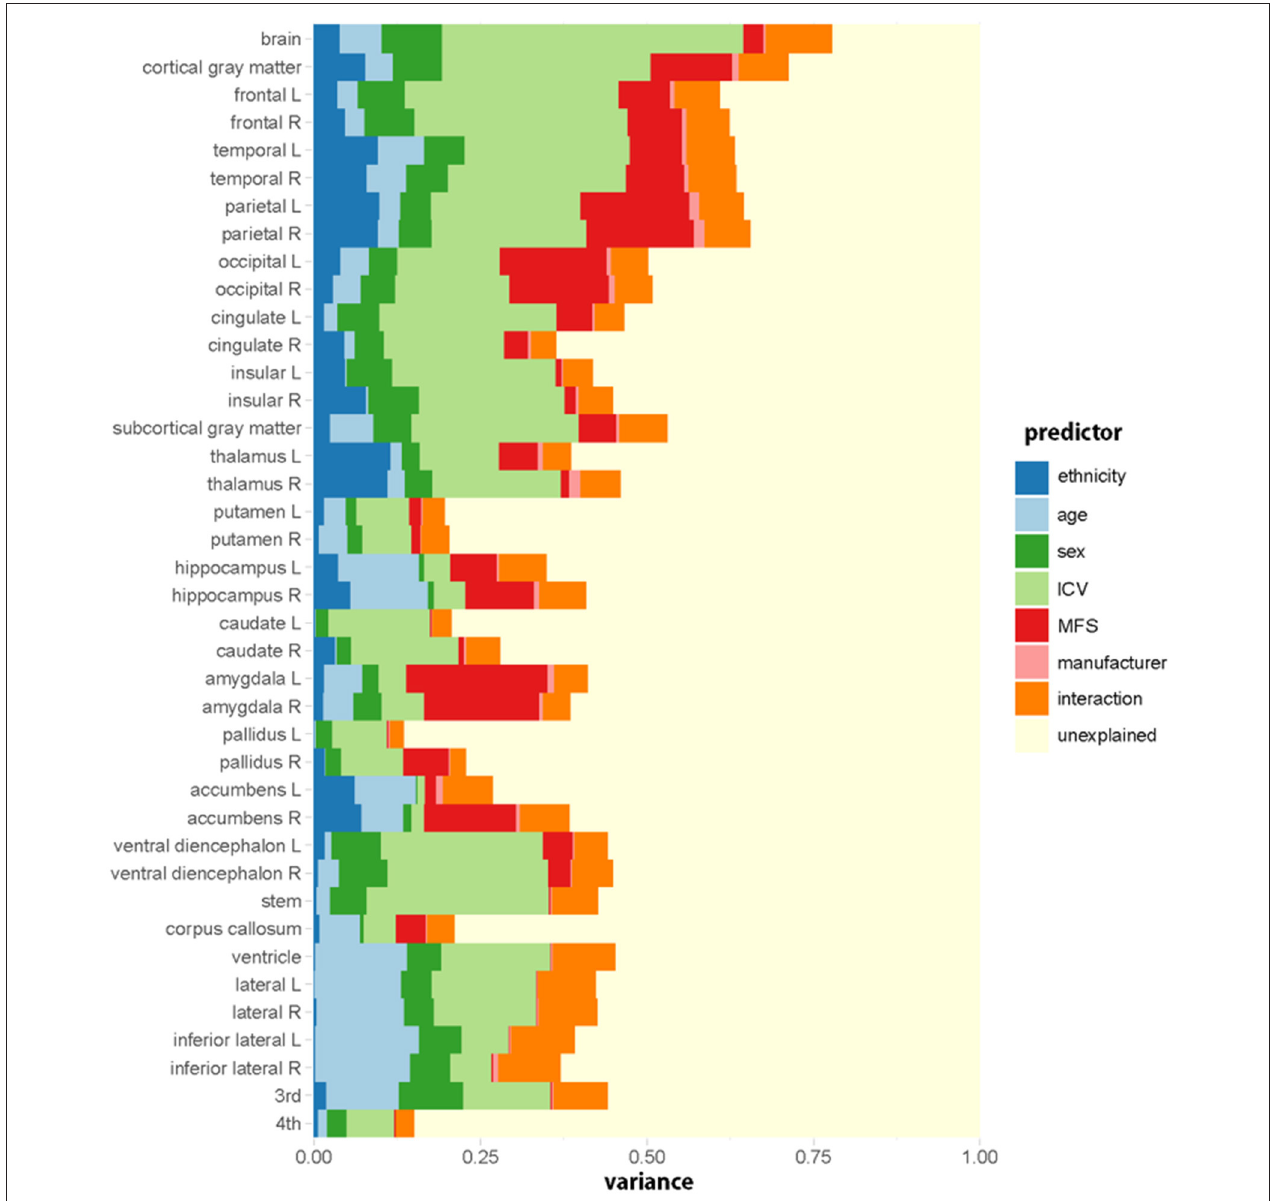
FIGURE 2 | Relative importance ( R 2 , proportion of the variance explained) of each predictive variable in the regression model for each regional volume. Ethnicity (dark blue) has a substantial effect on brain volumes. The relative importance is computed by averaging each predictor’s explained proportion of the variance over all orderings of predictors. Interaction indicates the sum of the proportions of variance explained by all the interaction terms.